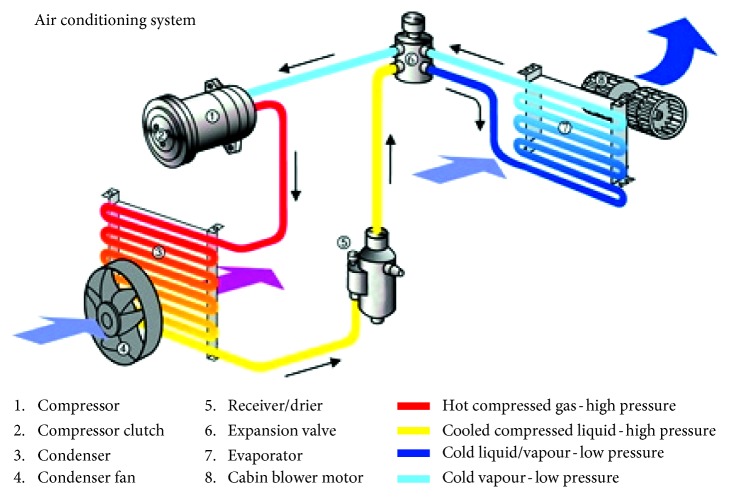
Vehicle air conditioning system [24].